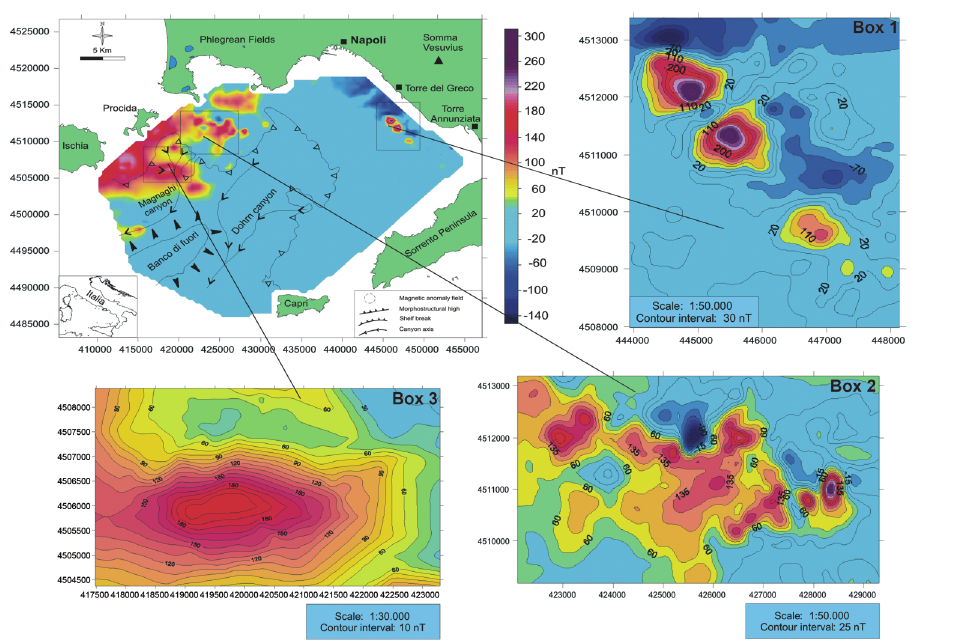
Fig. 2. High resolution magnetic anomaly map of the Gulf of Naples, reporting also main morphostructural lin- eaments recognized by the interpretation of Multibeam bathymetry. Box 1 represents a magnetic anomaly area located offshore the Somma-Vesuvius volcanic complex, while Box 2 represents another magnetic anomaly area located offshore the Phlegraean Fields volcanic complex. Box 3 represents a magnetic anomaly area located on the continental slope of the gulf, in the Magnaghi canyon’s head.